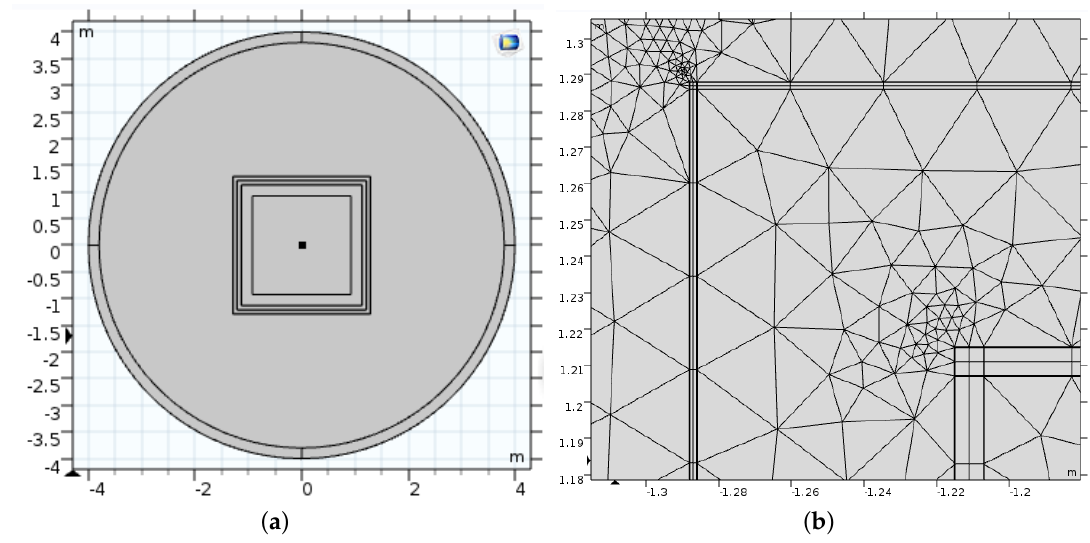
Figure 2. Geometry and meshing of the model. ( a ) The 2D geometry model of the MSR at HIT. ( b ) The meshing details of the model.